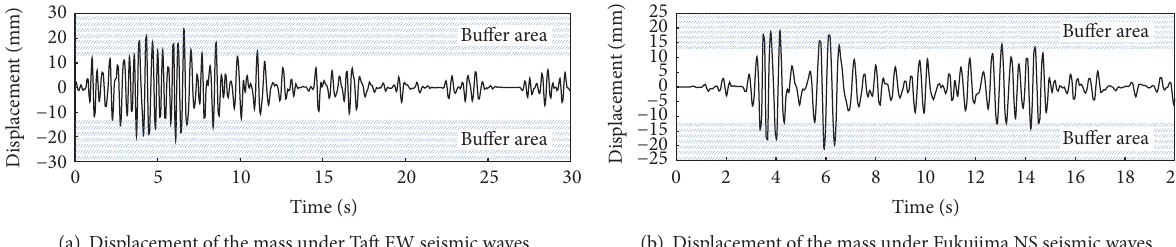
Figure 10: Amplitude responses of the mass of the bufferable TMD under Fukujima NS and Taft EW seismic waves: (a) displacement result under Taft EW and (b) displacement result under Fukujima